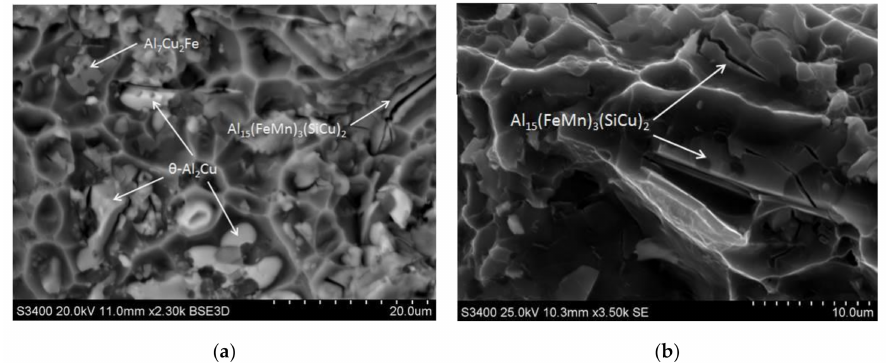
Figure 23. Images of fractures after precipitation strengthening and static tensile test, ( a ) the areas where the primary undissolved precipitates of the θ -Al 2 Cu phase occurred; ( b ) Al 7 Cu 2 Fe and α - Al 15 (FeMn) 3 (SiCu) 2 particles defragmented as a result of tensile